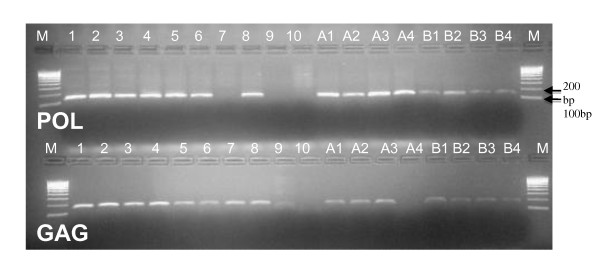
Gel picture of amplified products using 'in-house' HIV-1 gag and pol FP-DBS PCR assay. Gel picture of the HIV-1 pol (top panel - 160bp) and gag (lower panel - 152bp) PCR products. Lanes labeled from 1- 10 are PCR products from the ACH copy number controls: 1-2 are 100 HIV copies; 3-4 are 10 copies; 4-8 are 2 copies; 9 and 10 are negative controls using DNA from an uninfected T cell cell-line and water as the PCR template, respectively. PCR results from two samples of DBS-FP from infants who tested positive with the Roche Amplicor assay are labeled as A1-A4 and B1-B4, with 1-4 indicating quadruplicate tests. Based on the results show, both infants would be defined a HIV-1 DNA PCR positive according to testing algorithm for the' in-house' gag and pol FP-DBS FP PCR. The first and last lane in the gel picture (labeled M) in both the panels is the molecular weight marker - Hyperladder IV.